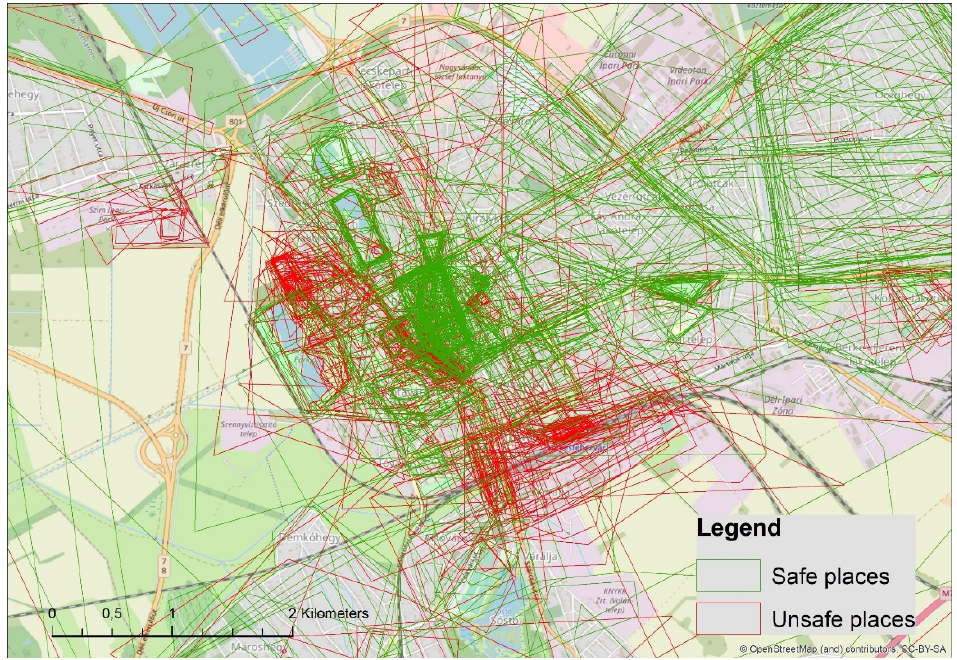
Figure 1. Polygons drawn by participants indicating safe and unsafe places in the survey in Székesfehérvár.